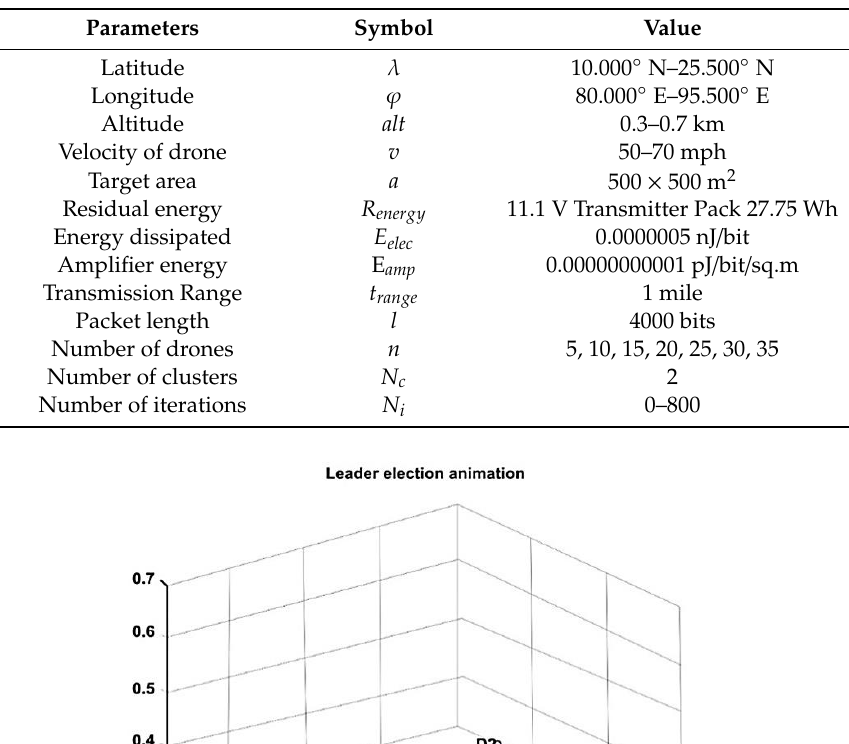
Table 1. Network parameters and specifications for BOLD.